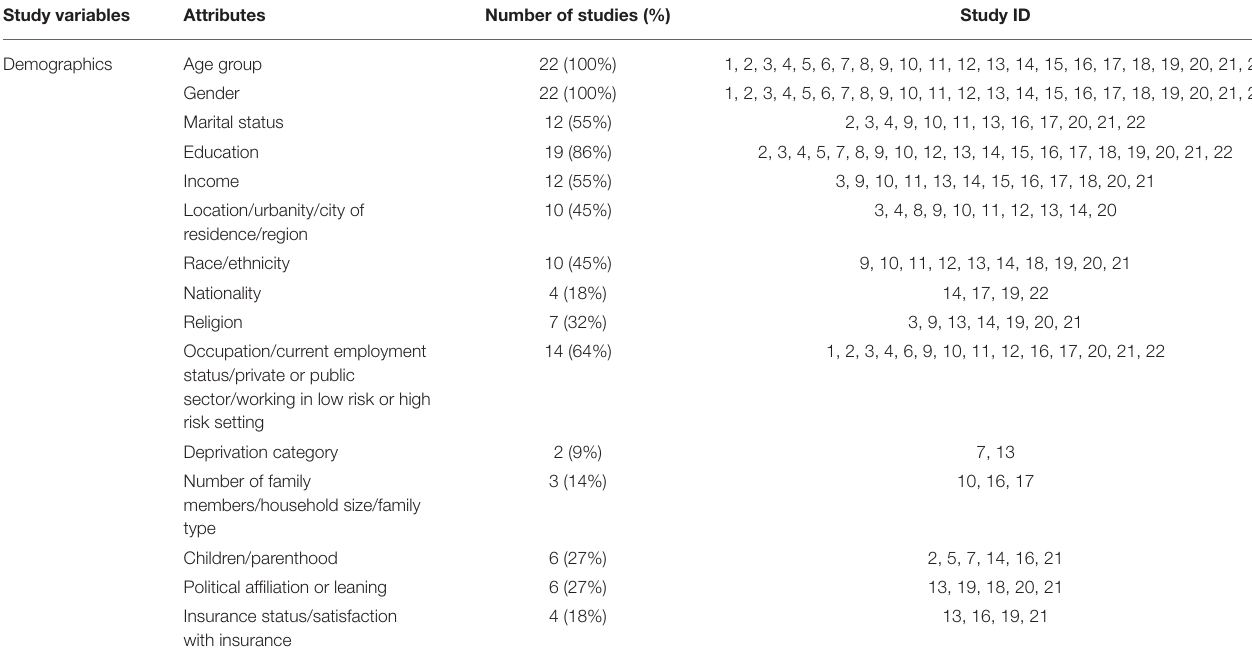
TABLE 3 | Socio-demographic variables examined in included COVID-19 surveys studies. Study